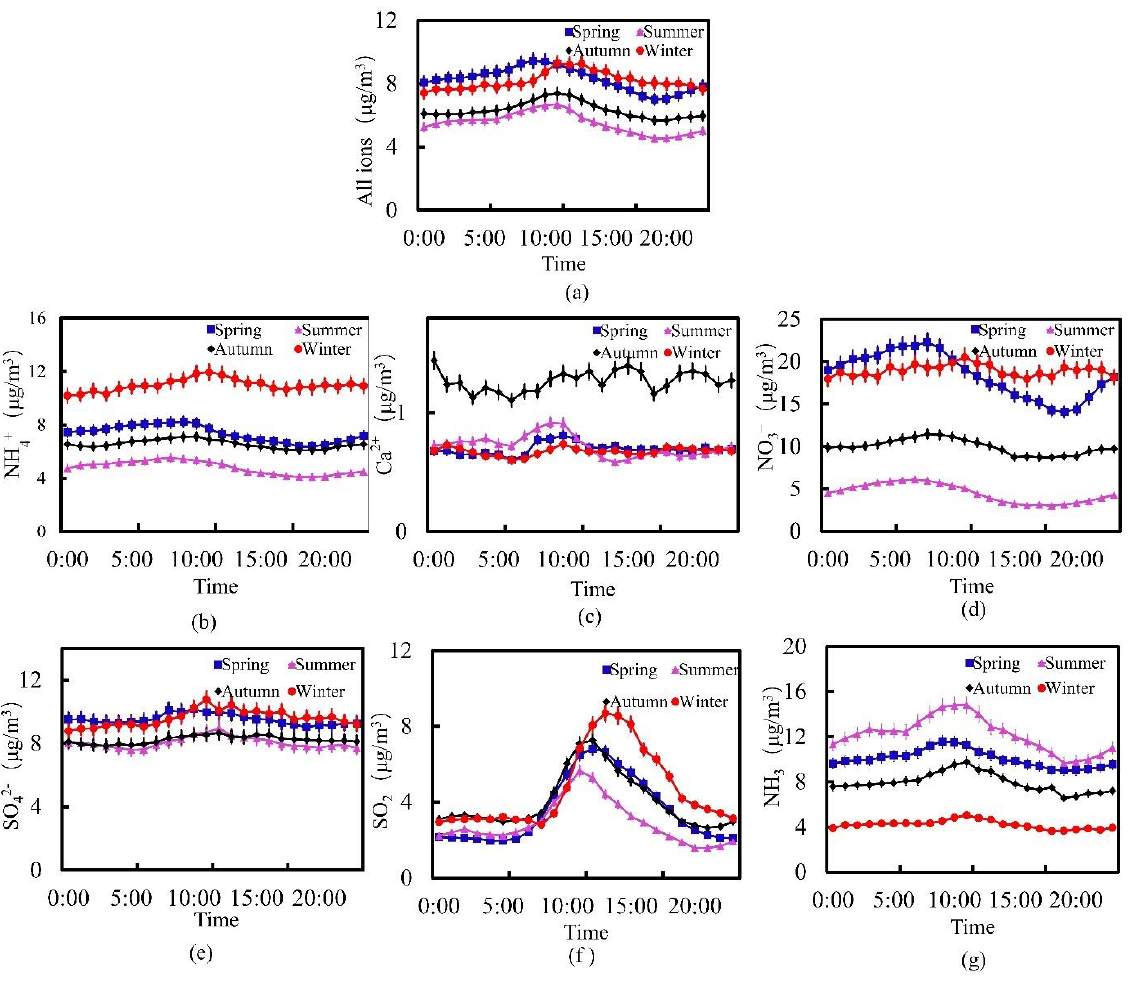
Figure 3. Seasonal changes in the water-soluble ion concentrations. ( a – g ) Changes in the water-soluble ion concentrations of NH 4+ , Ca 2+ , NO 3- , SO 42 − , SO 2 , and NH 3 , respectively.